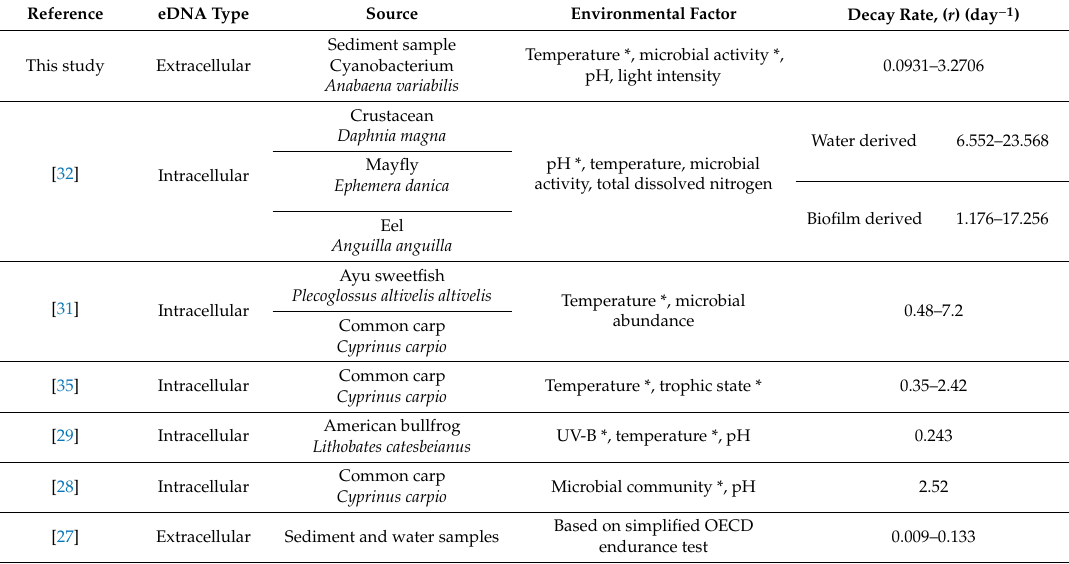
Table 4. Comparison of eDNA decay rates among di ff erent eDNA types, sources, and environmental factors. * indicate the factors that had a significant e ff ect on eDNA degradation in the respective study. eDNA: Environmental DNA, UV-B: Ultraviolet B light, OECD: Organization for Economic Co-operation and